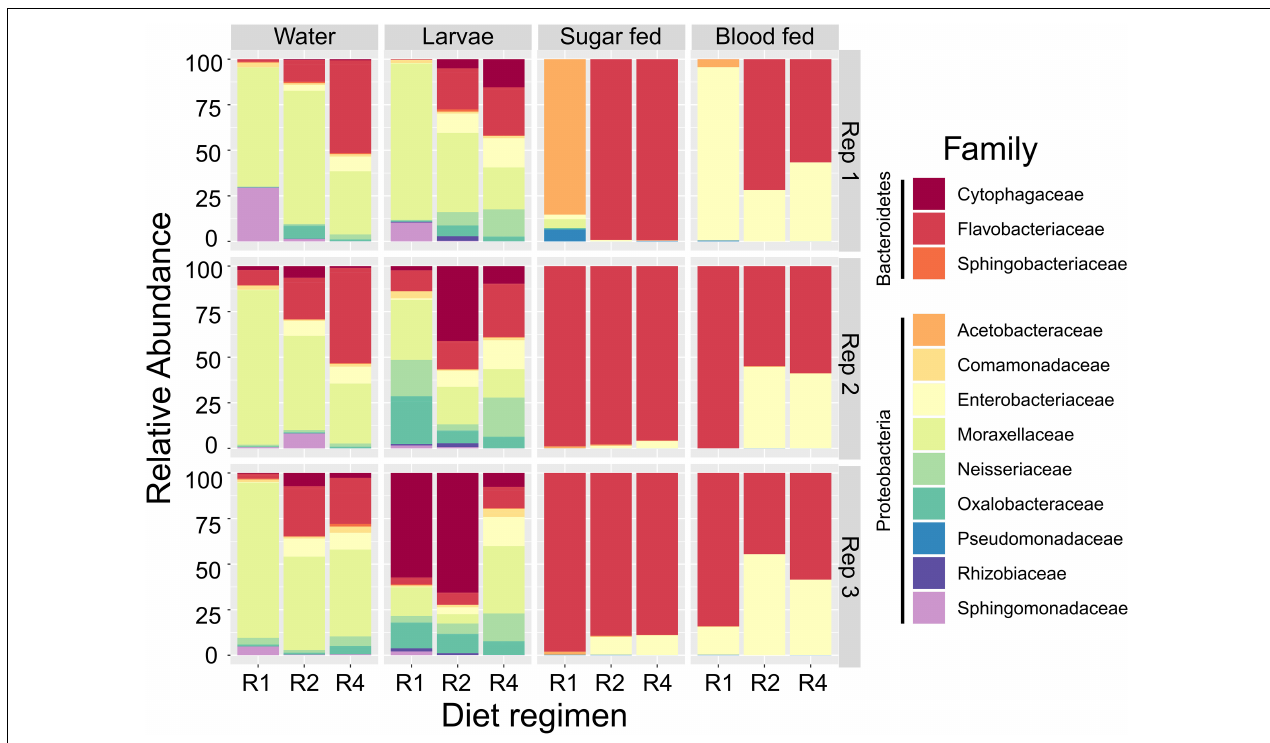
FIGURE 3 | Larval diet abundance impacts microbiota composition. Percent composition of bacterial families in larval breeding water, larvae, adult sugar fed midguts, and adult blood fed midguts from three feeding regimens (R1, R2, and R4, Table 1 ) and three biological replicates. Taxa containing fewer than 0.1% of all reads in the entire dataset were